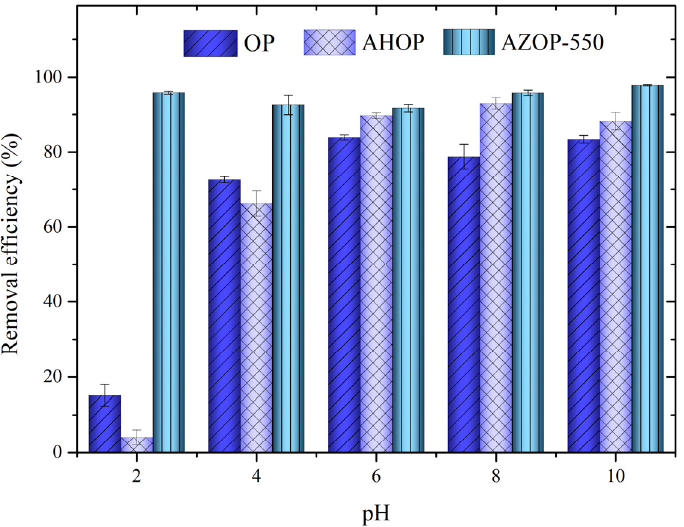
Figure 4. Effect of pH in the MB adsorption for the different substrates under study.